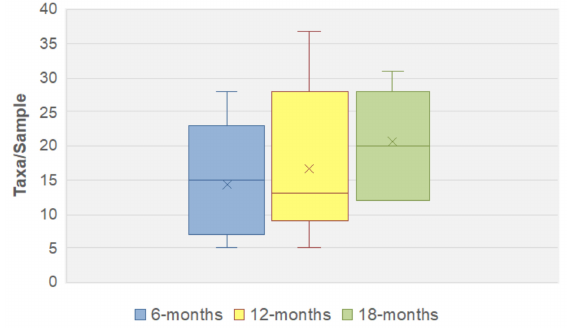
Figure 4. Fungal alpha-diversity depicted by a box-and-whisker plot showing number of taxa detected in each faecal sample for infants with 3 longitudinal samples. The horizontal line represents the median marker and ‘ × ’ represents the mean marker.